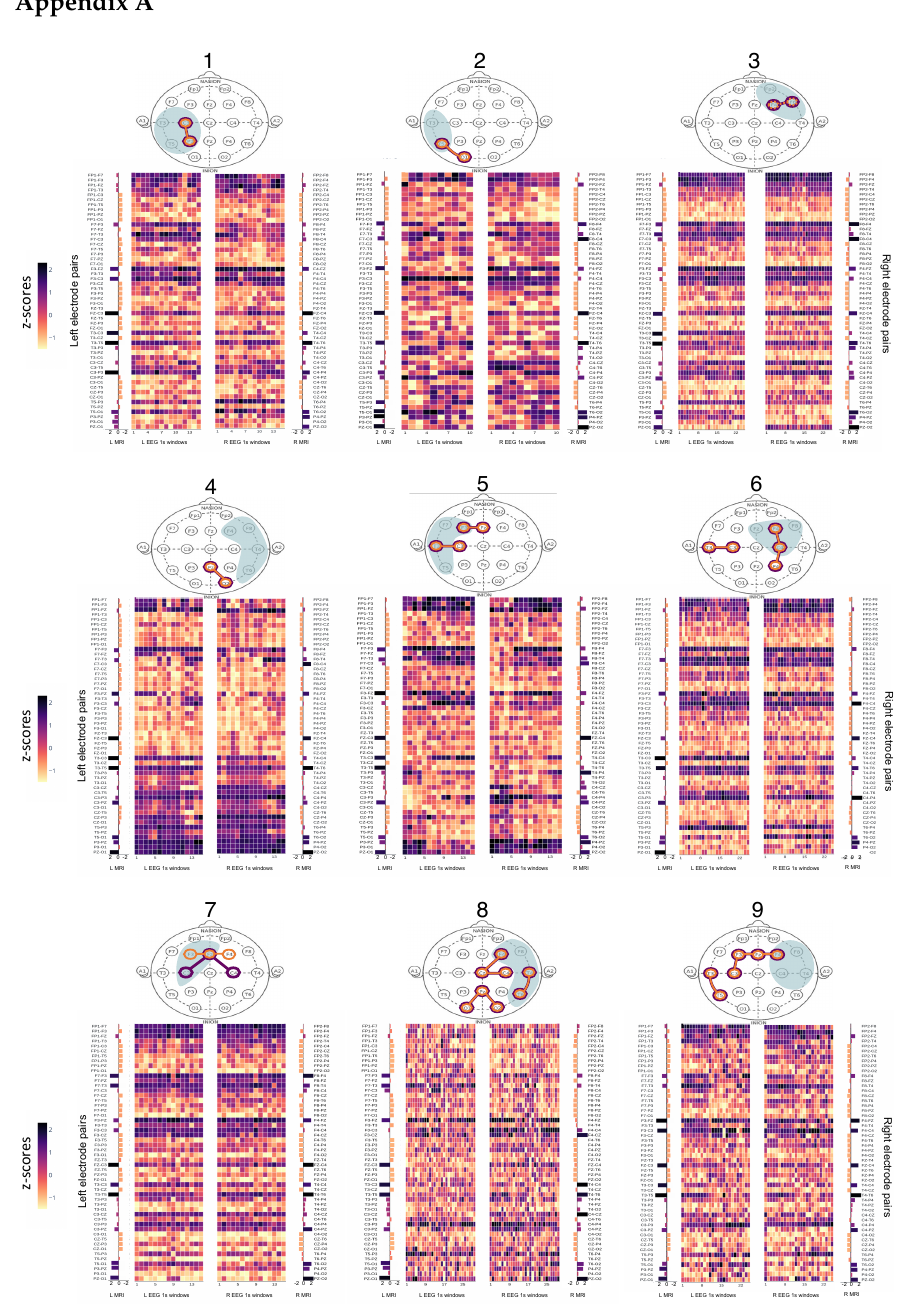
Figure A1. Heatmaps of z-scores from MRI and EEG connectomes. L: Left, R: Right. Patients are numbered 1–9 above each “head” and their respective connectomes are shown below the “head” map in the same grouping as Figure 2 in the main text. The “EEG 1s windows” depict the left and right side of each EEG connectome, split into 1 s windows. The structural (MRI) connectomes are split into left and right sides (“L MRI” and “R MRI”) and positioned alongside the matching EEG connectome side (i.e., left MRI next to left EEG connectome). The left and right electrode pairs are listed next to the respective side of the